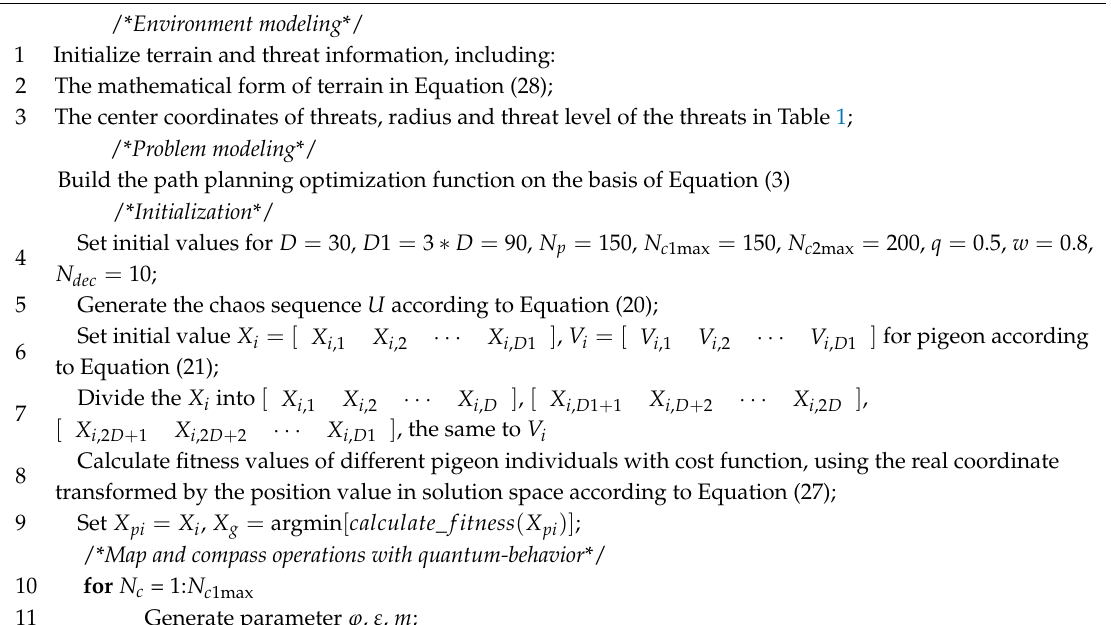
Algorithm 2: AOQPIO Based path